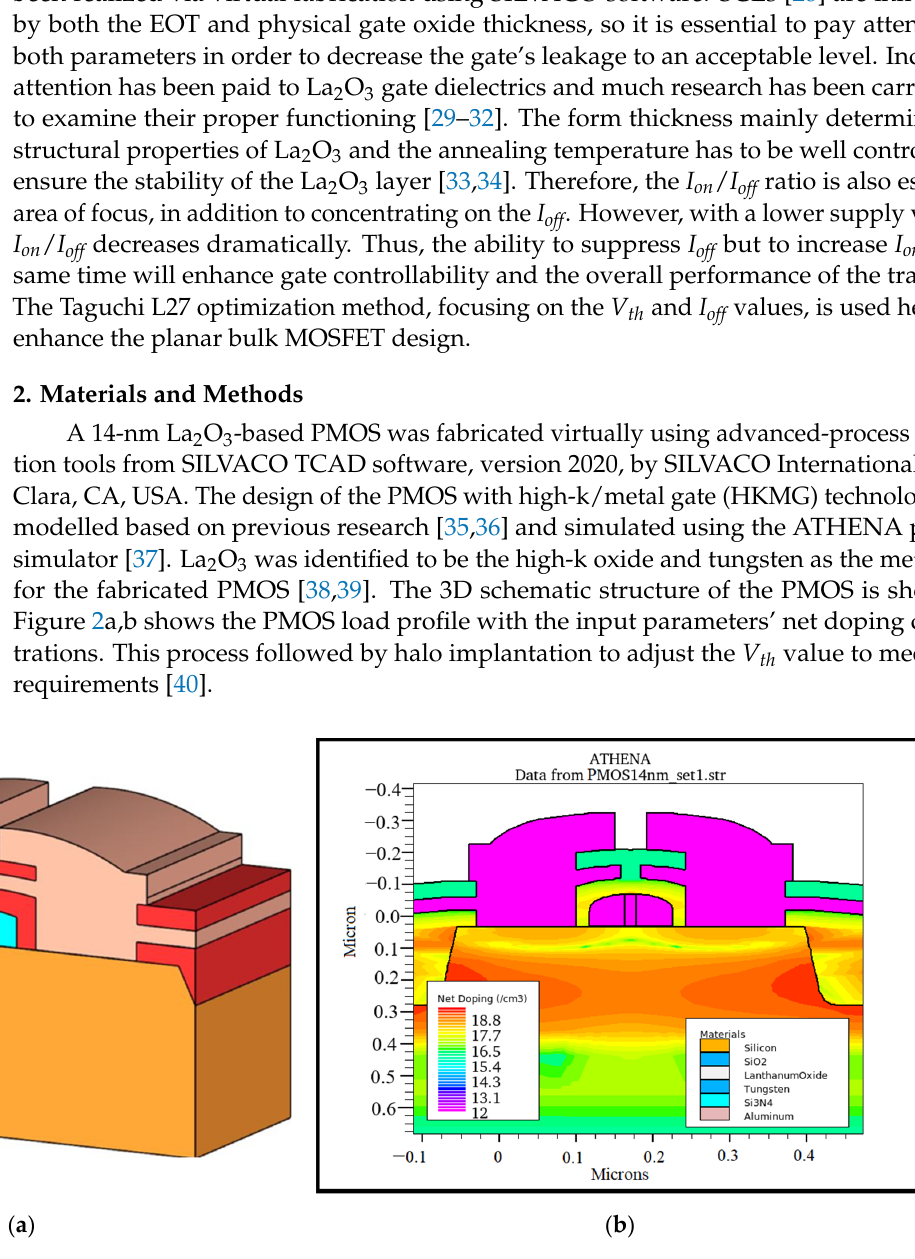
Figure 2. ( a ) Structure of 14-nm-gate-length PMOS; ( b ) load profile of 14-nm bulk PMOS.